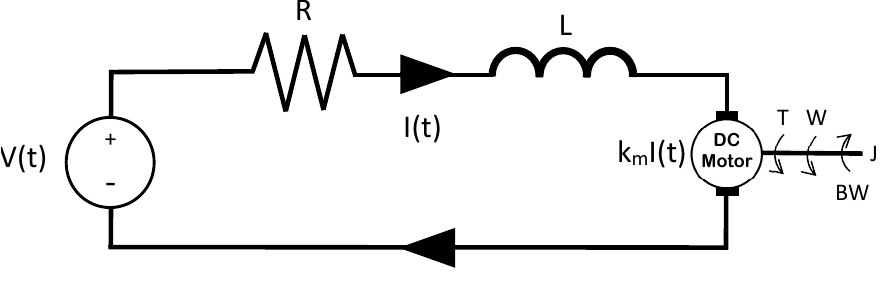
Figure 5. DC motor scheme used to obtain the second-order transfer function in electromechani- cal